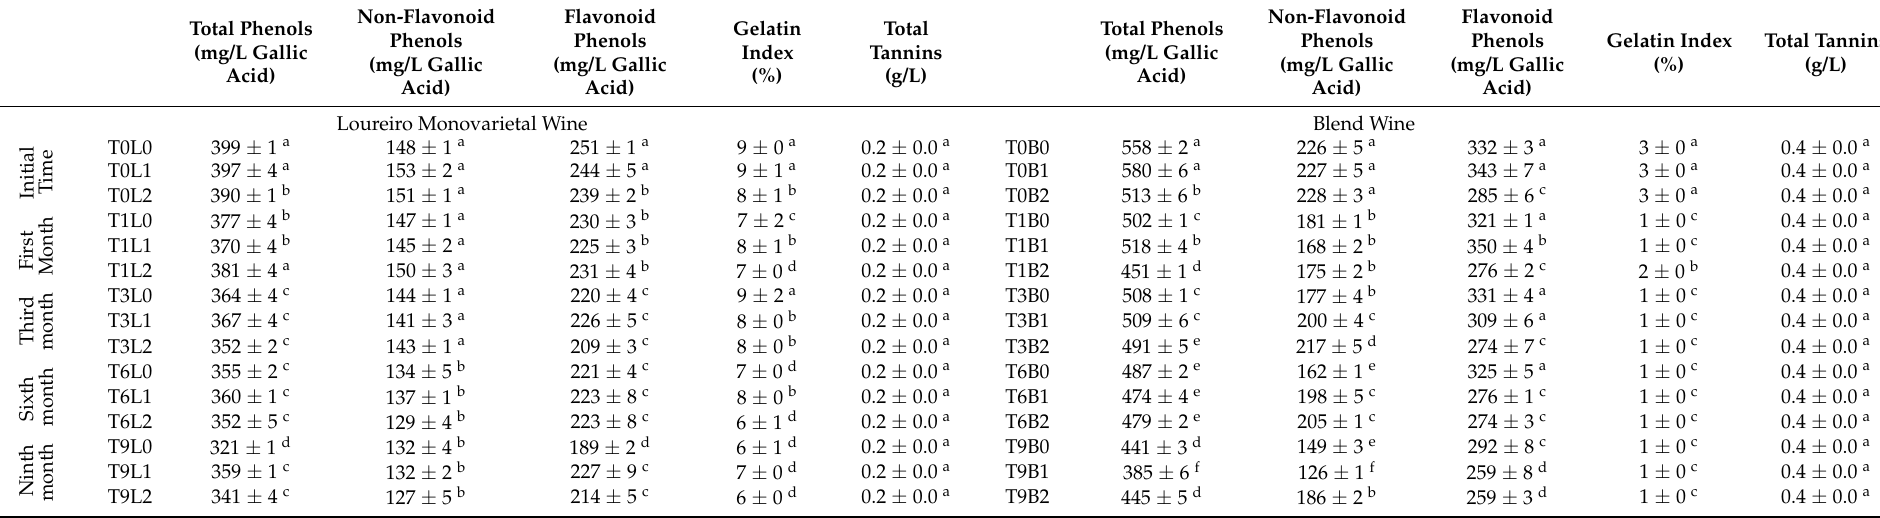
Table 5. Phenolic compounds of the Loureiro monovarietal wine and the Blend wine before and after transportation and deoxygenation over nine months (mean ± standard